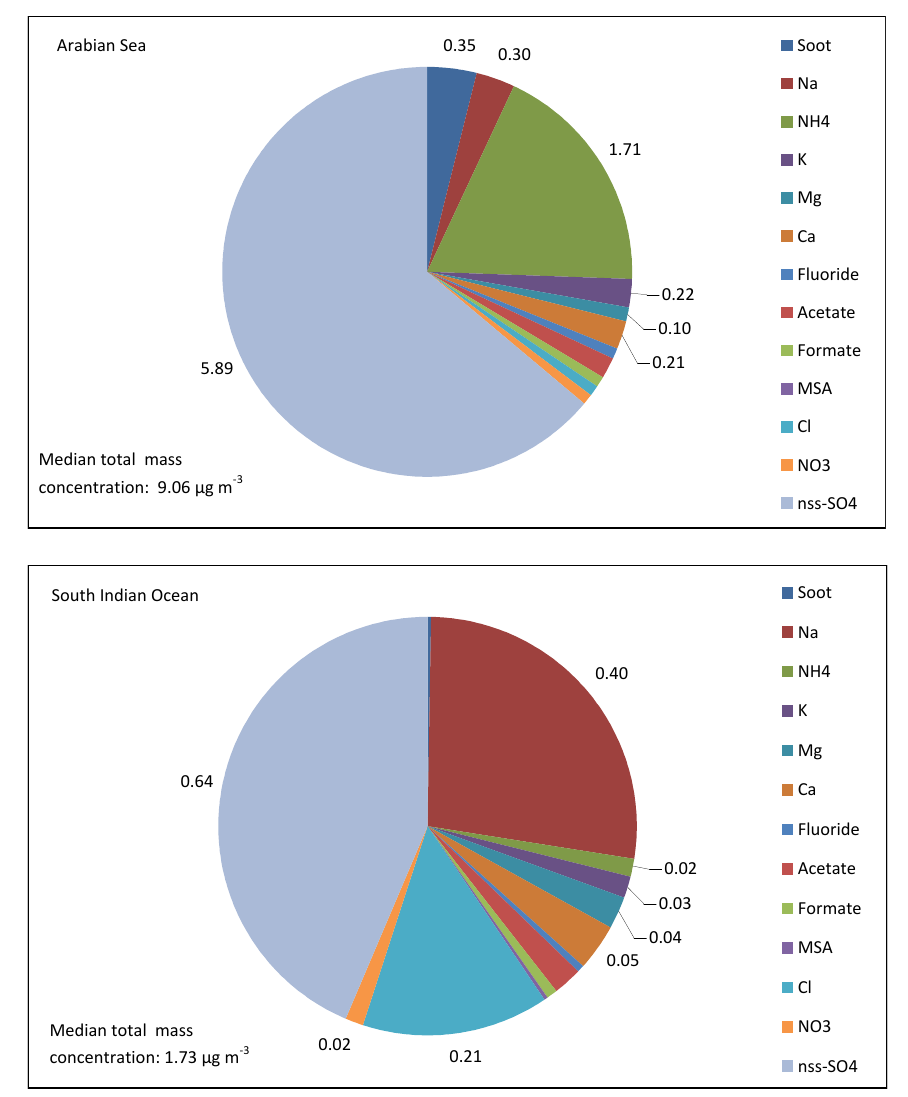
Fig. 5. Median aerosol composition and the sum of median ion mass and median BC mass (derived using the chemical correction) for the two data selections. Units are given in µgm − 3 . BC mass concentrations were derived using a mass absorption cross-section of 10 ± 1m 2 g − 1